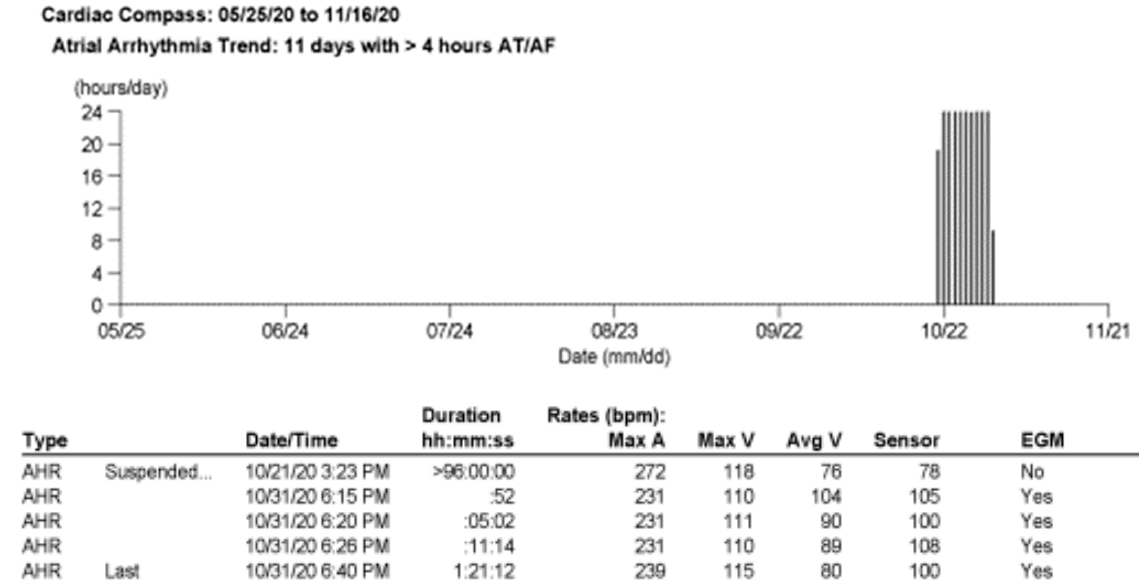
Figure 3. Remote control of PM about FLA.